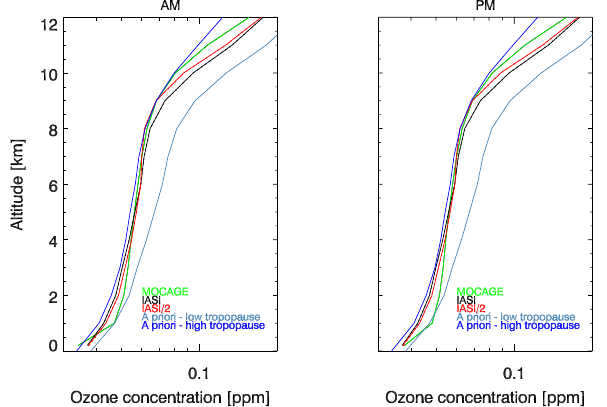
Fig. 5. Mean ozone profiles for August 2009, for MOCAGE pseudo-reality (green line), IASI (black line) and IASI/2 pseudo- observations (red line), low tropopause/mid-latitude (sky blue line) and high tropopause/tropical a priori (blue line); AM (left), PM (right)